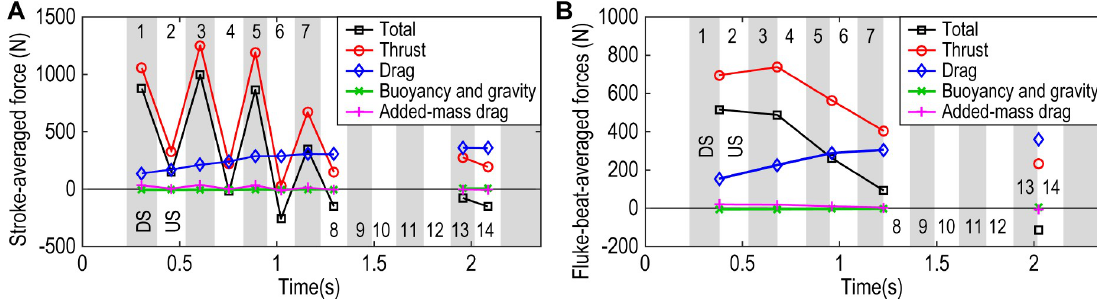
Fig 11. Calculated forces. (A) Stroke-averaged values. (B) Fluke-beat-averaged values. Grey region and white region represent downstroke and upstroke, respectively. See also S5 and S6 Datasets for time-series force and drag coefficient data and averaged force data, respectively.